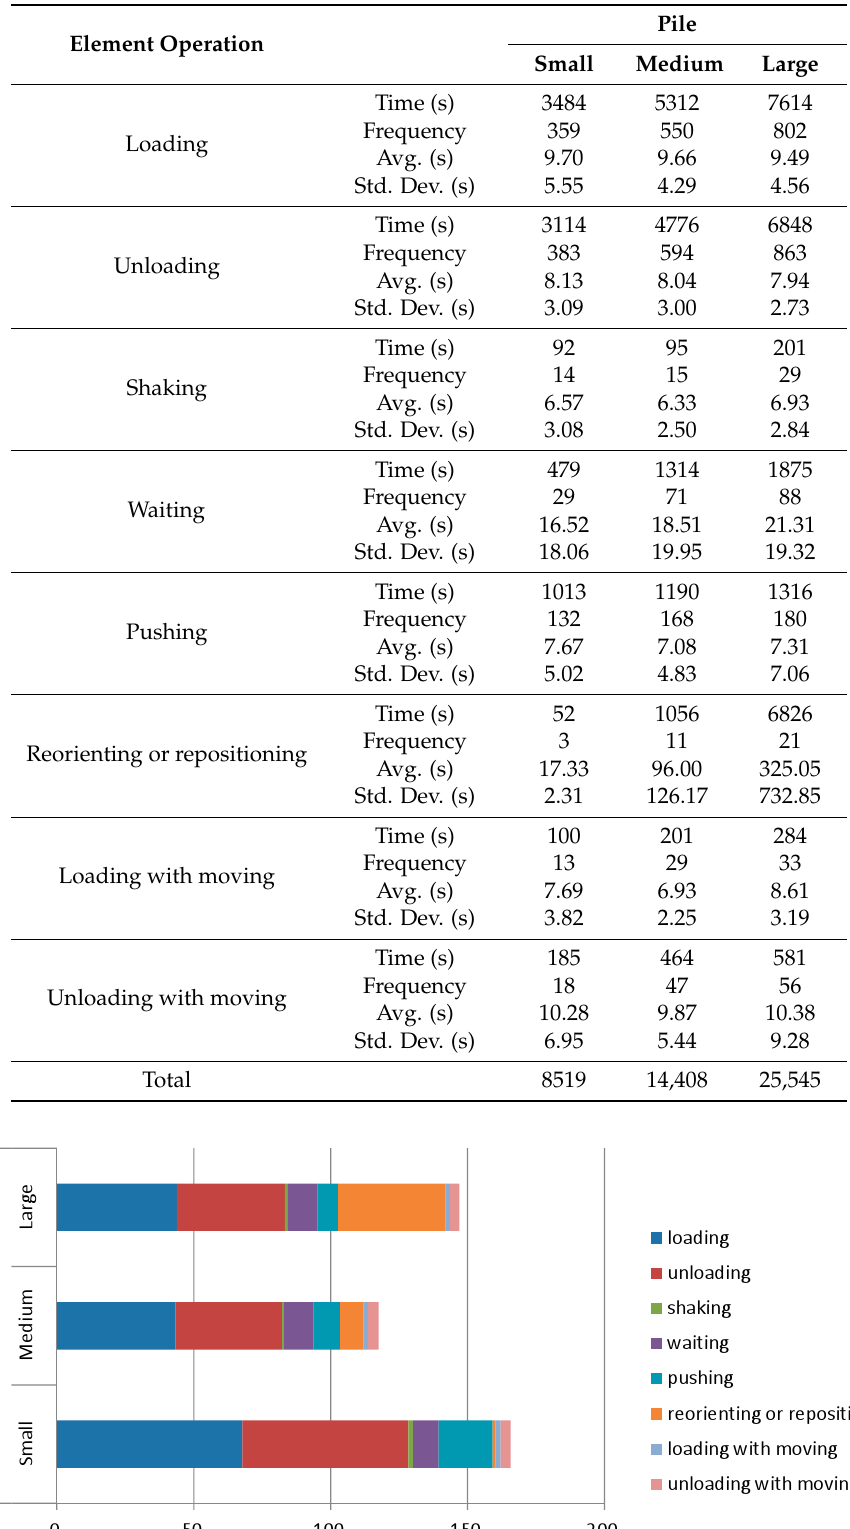
Table 2. Results of the time study.